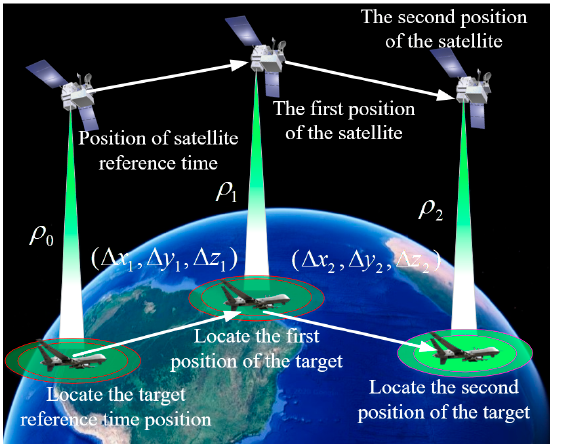
Figure 1. Schematic diagram of single-satellite positioning.